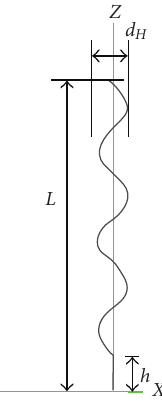
Figure 2: The NMHA with L = 25mm, d H = 2 . 6mm, h = 3mm and d w = 0 . 6